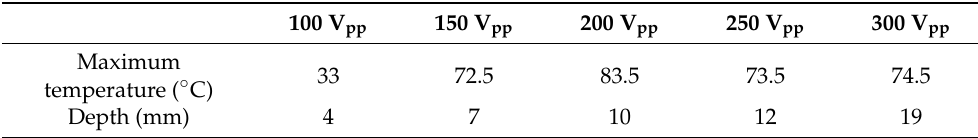
Table 2. Maximum temperature and depth of exposed